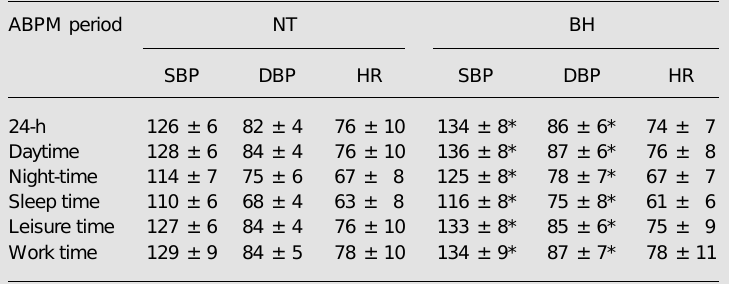
Table 2. Twenty-four-hour ambulatory blood pressure monitoring (ABPM) of systolic blood pressure, diastolic blood pressure and heart rate in the normotensive (NT) and borderline hypertensive (BH)